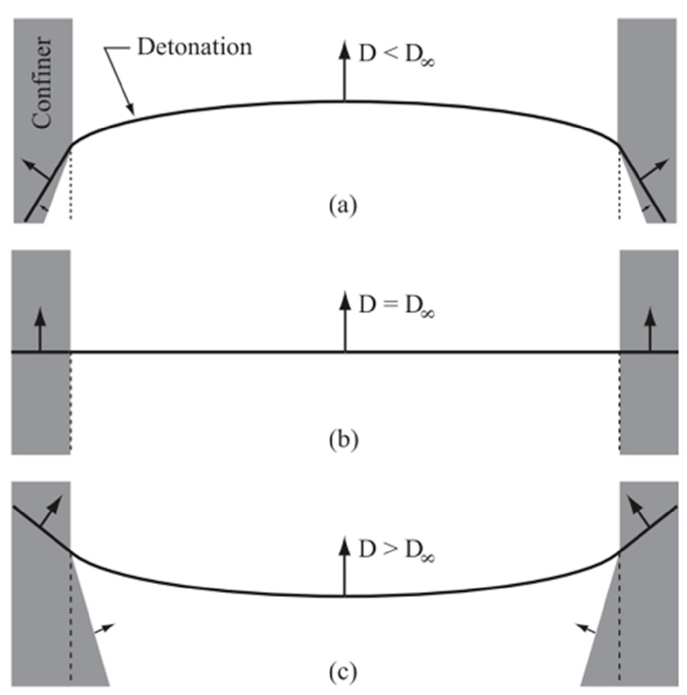
Figure 1. Different types of confinement: ( a ) sink, ( b ) perfect, and ( c ) energetic [1]. D, detonation velocity; D ∞ , ideal detonation velocity.